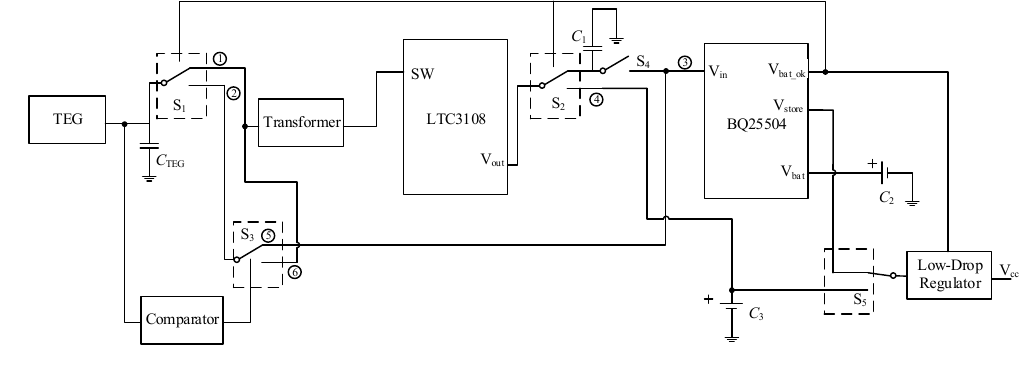
Figure 2. Proposed PMS circuit diagram.